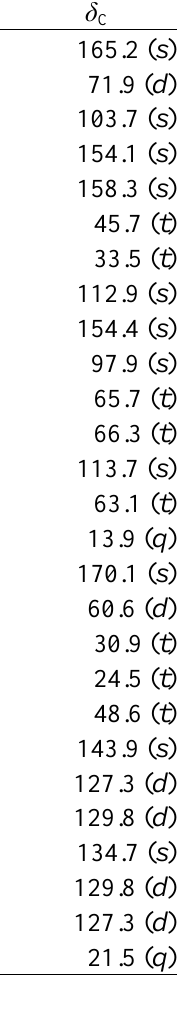
Table 1. 1 H- and 13 C-NMR data for 4a in CDCl